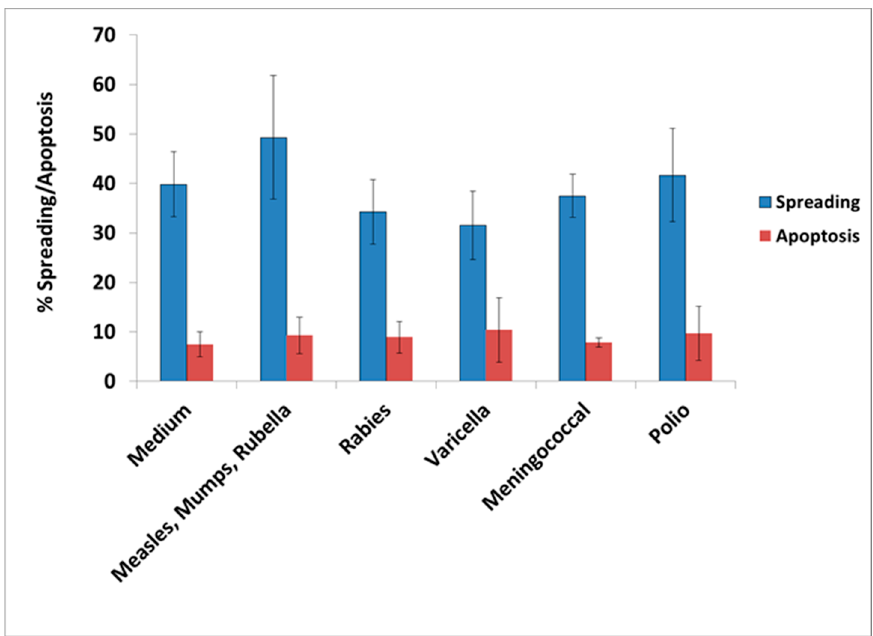
Figure 4. Percentage cell spreading and apoptosis in N2A cells cultured for 48 hours in the absence (medium) or presence of each of the vaccines: MMR (measles, mumps, rubella), r abies, varicella, Neisseria meningitis , and polio virus. These vaccines did not have a significant effect on cell spreading or apoptosis of N2A cells compared to the control (medium) by the paired t ‐ test.